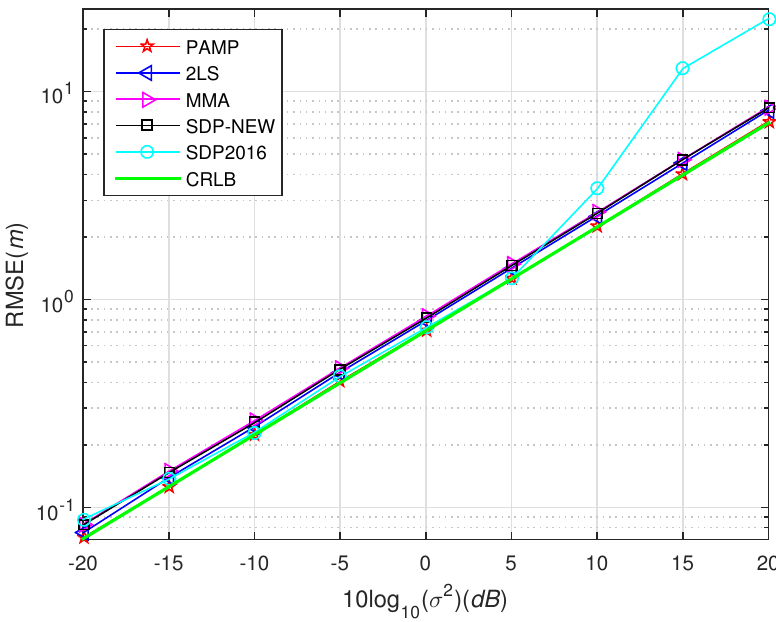
Figure 4. Root-mean square error (RMSE) versus σ 2 using different methods, near-field case in scenario